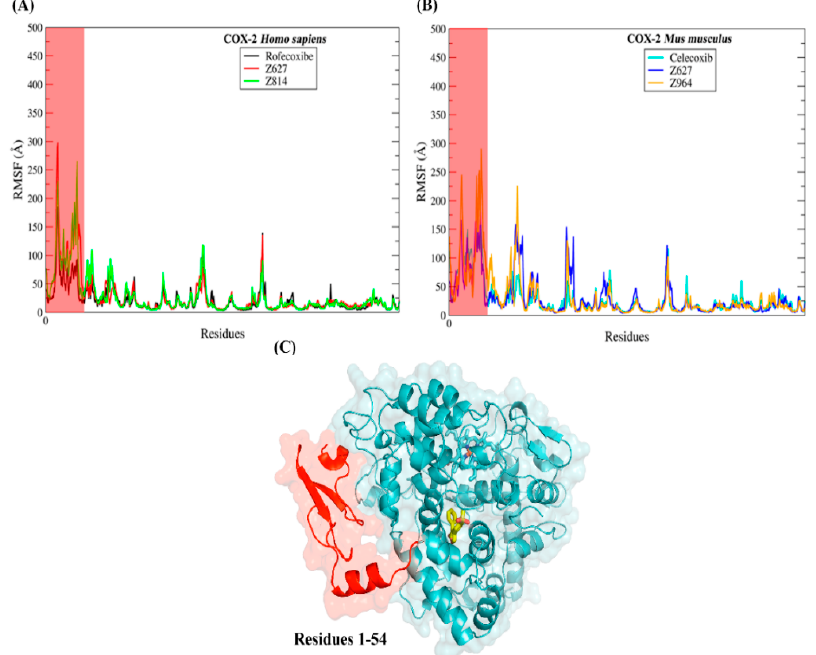
Figure 13. Root mean square fluctuations (RMSF) plot of the backbone of the proteins that established complexes with the compounds obtained by virtual screening. ( A ) RMSF for the COX-2 Homo sapiens; ( B ) RMSF for the COX-2 Mus musculus. ( C ) The region of the protein that has undergone the greatest fluctuations is highlighted in red.